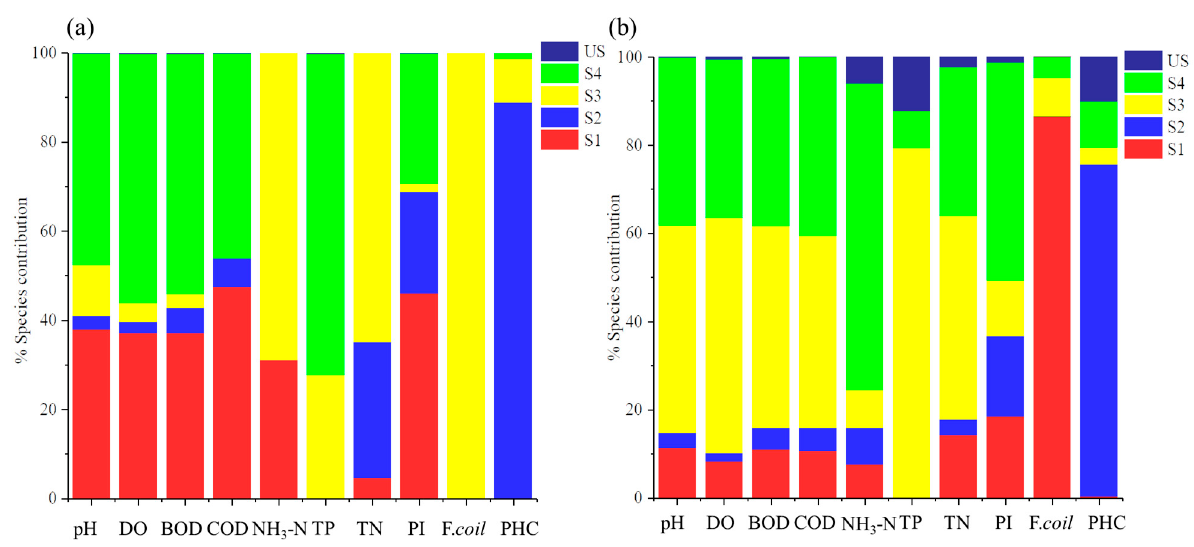
Figure 6. Contributions of pollution sources for ten studied variables based on the positive matrix factorization (PMF) model in the LP ( a ) and HP ( b ) zones. The S1, S2, S3, S4, and US in LP zone were identified as point source pollution of industrial sewage, point source of petrochemical enterprises wastewater, non-point source pollution of overland runoff, point source pollution of domestic sewage, and one undefined source, respectively. The S1, S2, S3, S4, and US in the HP zone were identified as non-point source pollution of overland runoff, point source of petrochemical enterprises wastewater, point source pollution of domestic sewage, point source pollution of industrial sewage, and one undefined source, respectively.